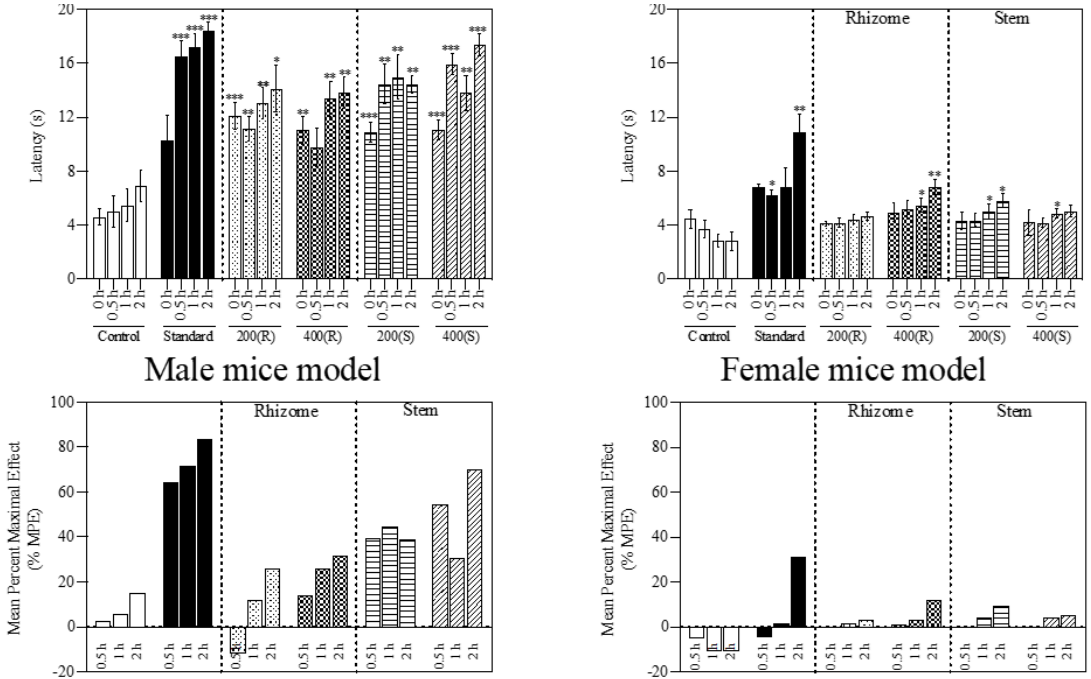
Figure 2: Effect of rhizome and stem extract of Schumannianthus dichotomus against thermally induced pain in male and female mice model. Data were presented as Mean ± SEM. Two-way ANOVA with Tukey multiple comparisons test was performed to determine statistical significance of test results; here, *p<0.05, **p<0.01 and ***p<0.001 vs